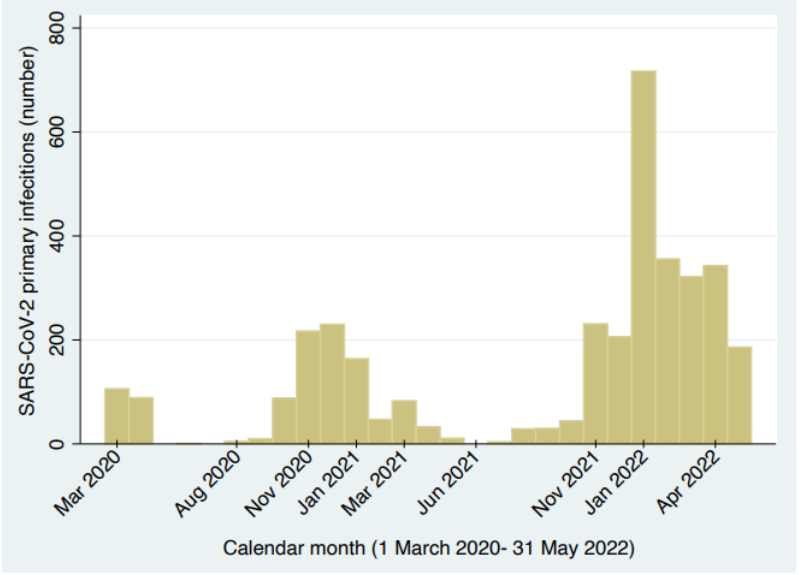
Figure 2. Number of primary SARS-CoV-2 infections ( N = 3571) in health care workers in ASUGI, by calendar month, 1 March 2020 – 31 May 2022.